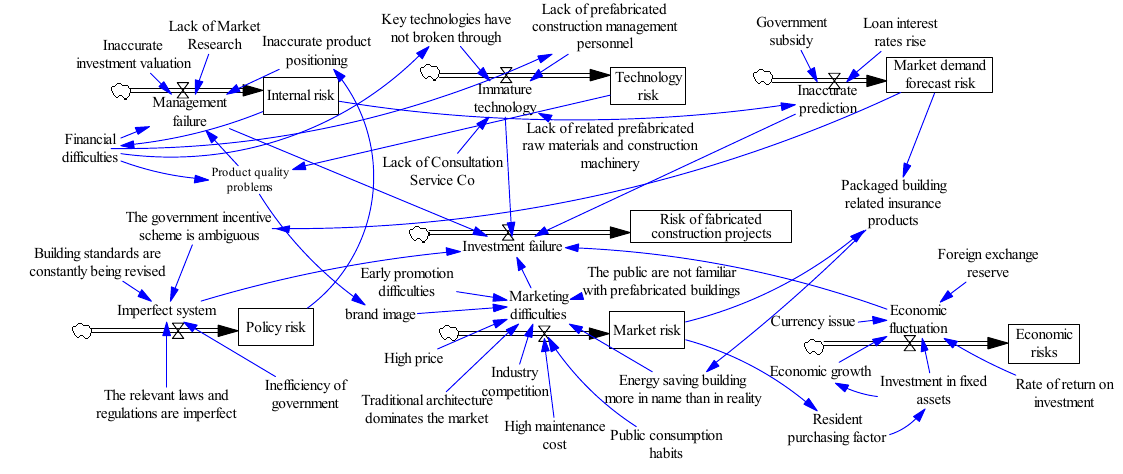
Figure 5. Model risk flow chart.